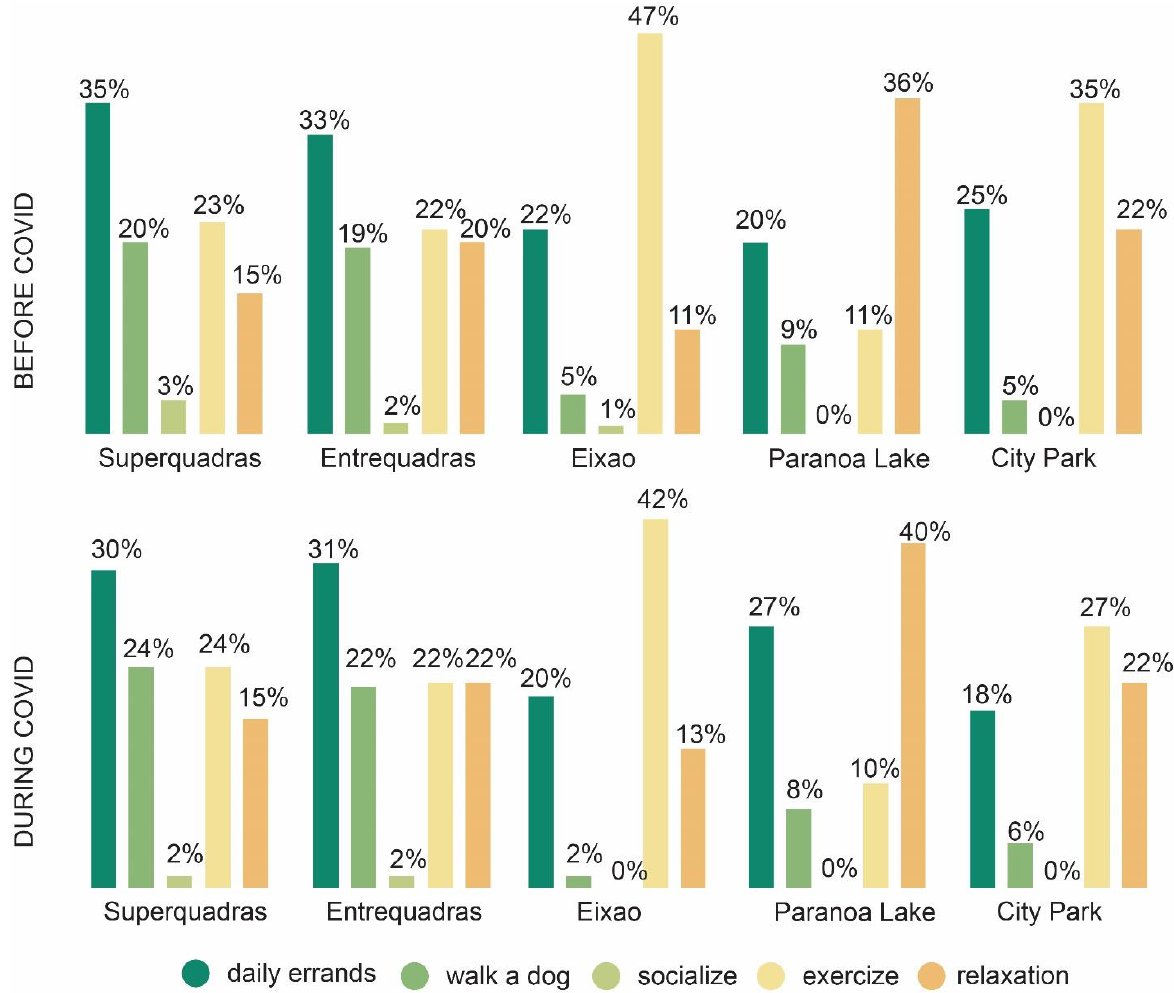
Figure 7: Difference between the type of usage of the 5 different types of public spaces in abosulte percentage from the survey. It is possible to make comparisons betweens types of public spaces, types of activities and time, considereing the pandemic. (Source: The Author,